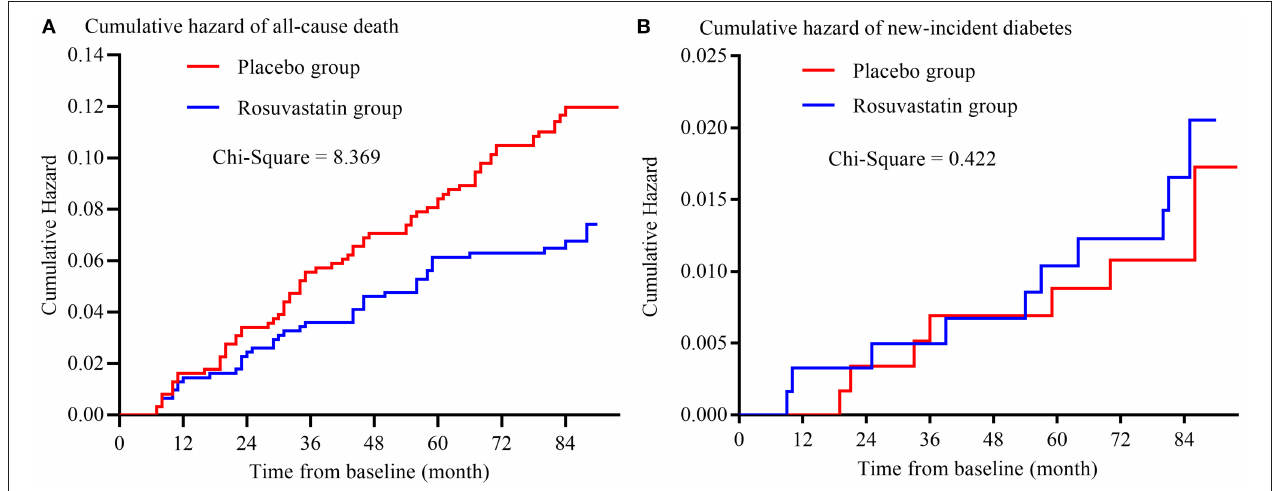
FIGURE 3 | Kaplan-Meier curve of secondary outcomes. (A) is the Kaplan-Meier curve of all-cause death; (B) is the Kaplan-Meier curve of new-incident diabetes.